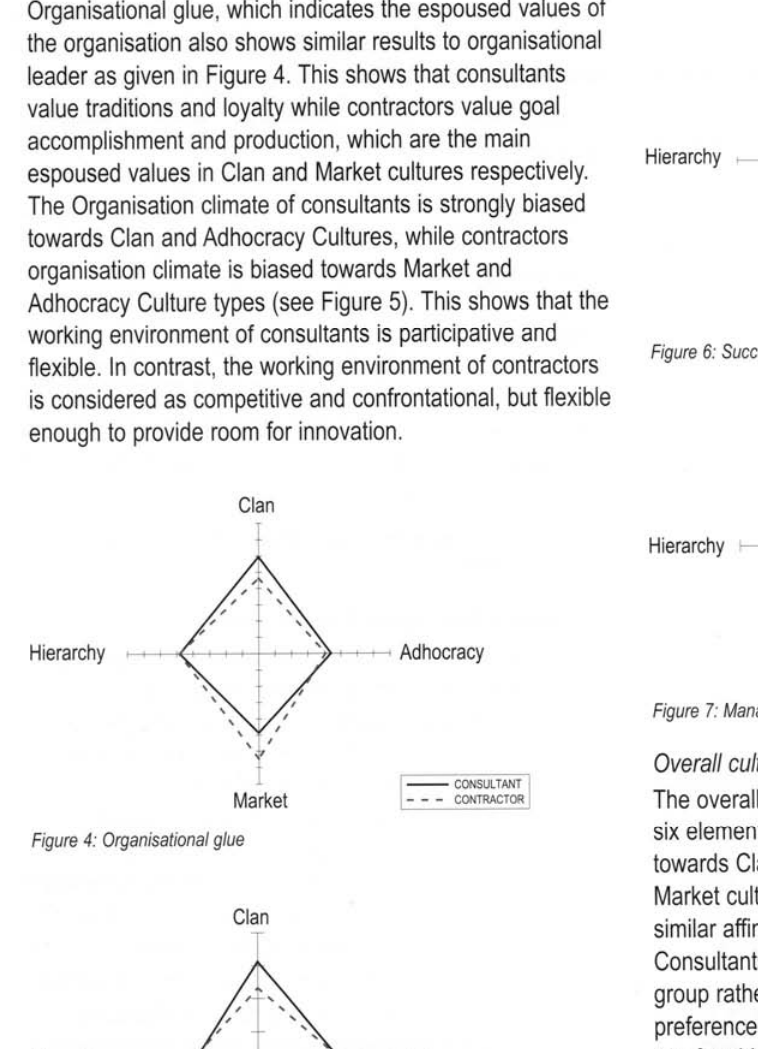
Figure 7: Management style